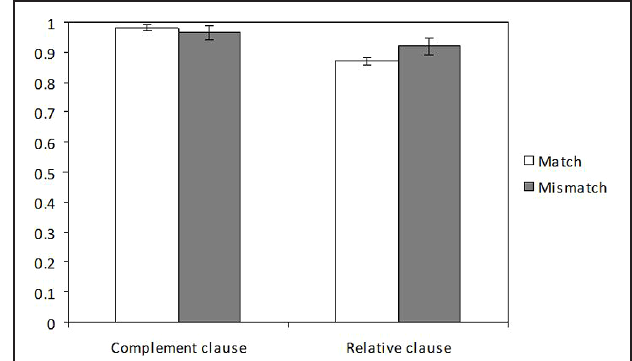
FIGURE 2 | Accuracy proportions in the comprehension questions of Experiment